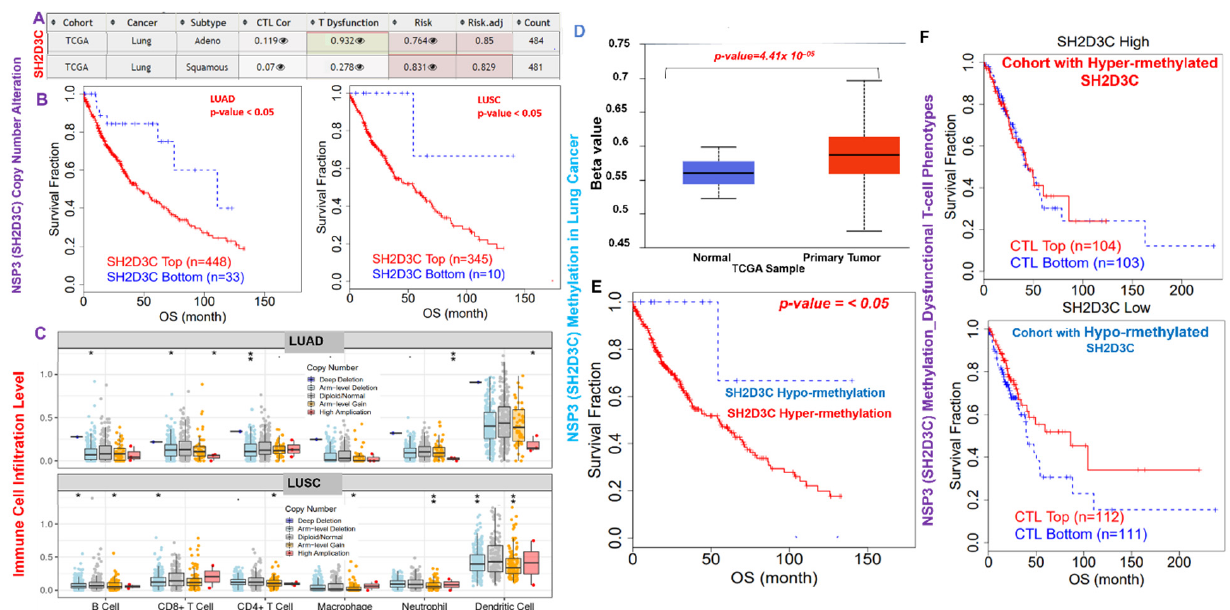
Figure 5. Non-structural protein 3 ( NSP3; SH2D3C ) methylation and copy number alterations (CNA) are associated with infiltration of immune cells and poorer prognosis of lung cancer cohorts. ( A ) Heatmap plot of the NSP3 (SH2D3C) expression and T-cell profile in LUAD and LUSC cohorts. ( B ) Kaplan–Meier plot of the overall survival differences between high and low CNA of NSP3 (SH2D3C) in LUAD and LUSC cohorts. ( C ) Boxplot showing the association between different somatic copy number alterations and infiltration of various immune cells in LUAD and LUSC. ( D ) Boxplot showing differential NSP3 (SH2D3C) methylation between lung cancer tumors and adjacent normal tissue. ( E ) Kaplan–Meier plot of the overall survival differences between lung cancer cohorts with high and low methylation levels of NSP3 (SH2D3C) . ( F ) Kaplan–Meier plot of the overall survival of lung cancer patients with different NSP3 (SH2D3C) methylation status and CTL levels. The “eye” sign represent the hidden view of the CTL, dysfunctional and risk plots of the cohorts